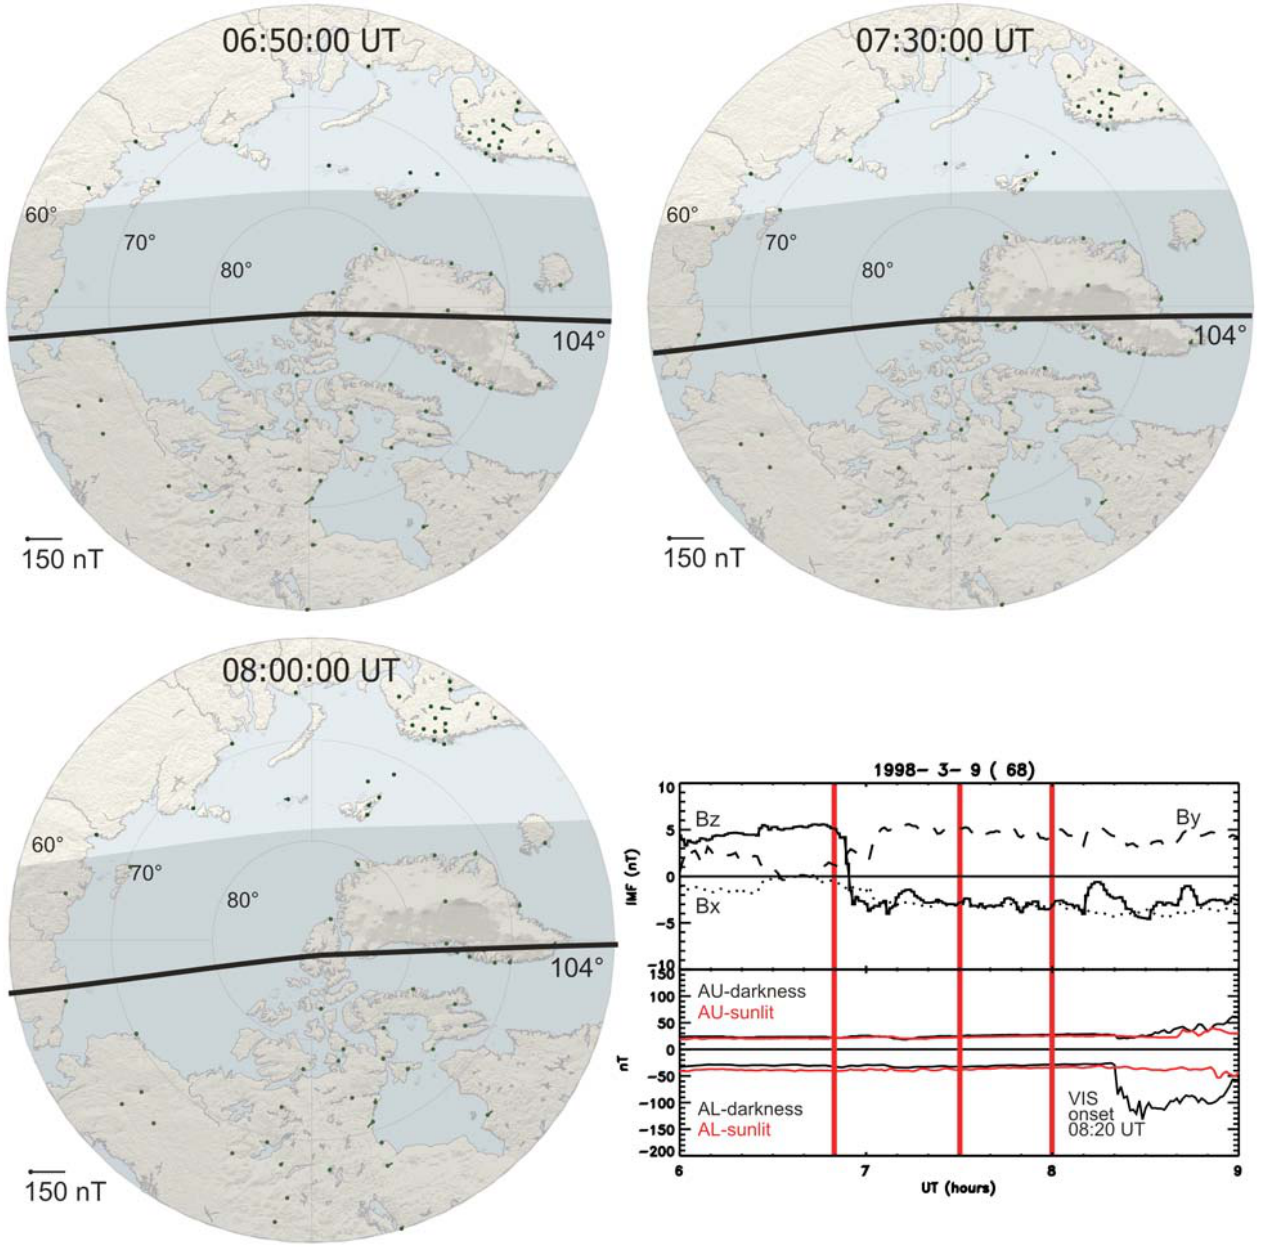
Fig. 1. A typical event from 9 March 1998 when most of the auroral region was in darkness. Superposed onto the polar plot are ground magnetic field vectors (units of nT) rotated 90 ◦ clockwise to indicate the equivalent current direction. Both the 90 ◦ and 104 ◦ terminators are shown on the plot. The line plots show the three components of the propagated IMF and the AU/AL indices determined from sunlit stations (AUs/ALs) and stations in darkness (AUd/ALd). Vertical red lines indicate the time of the polar plots. Images obtained by the VIS Earth Camera carried on the Polar satellite show the onset of a weak substorm at